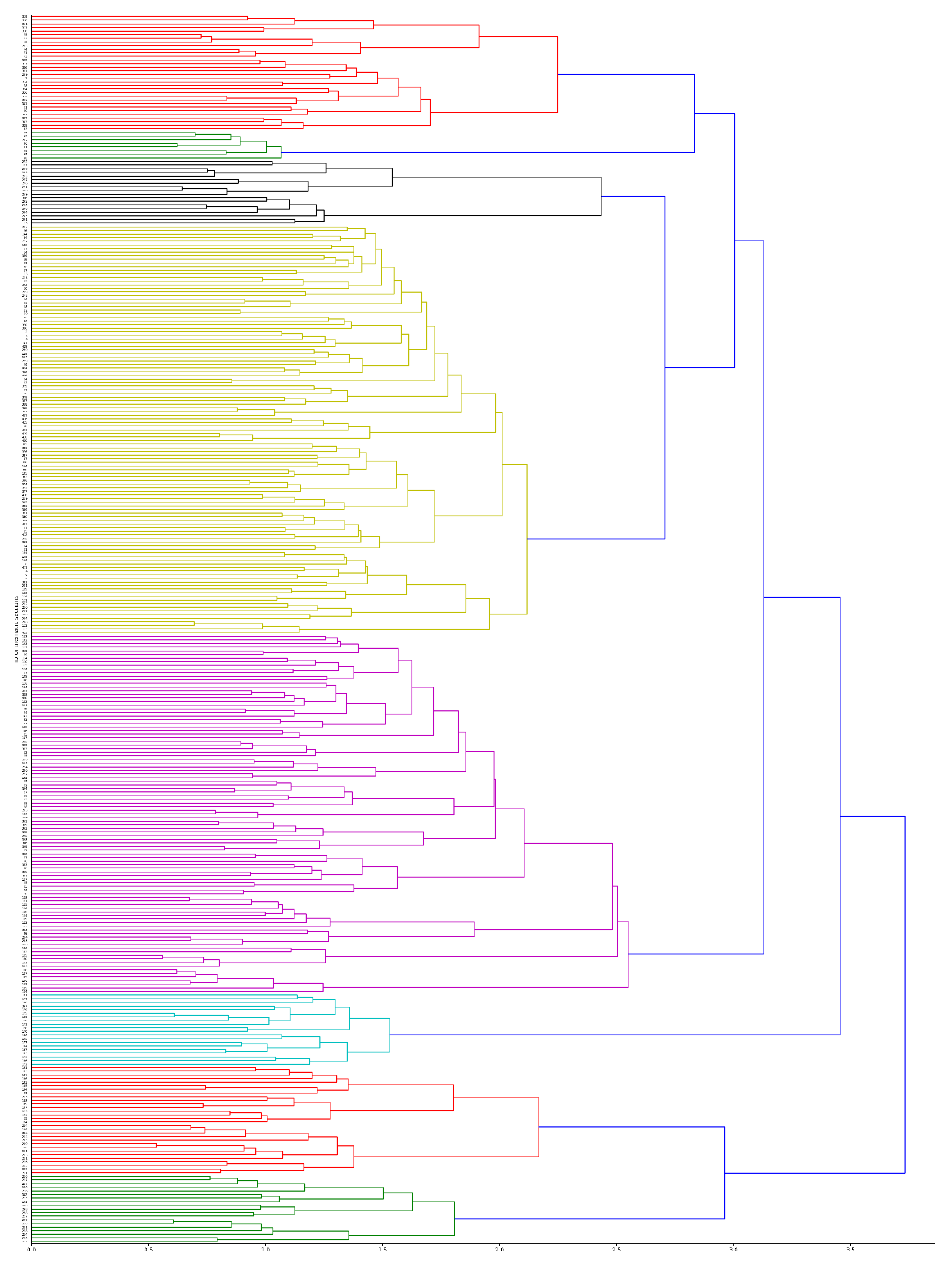
Figure 3. Dendrogram based on hierarchical clustering with Ward’s method and Euclidean distance performed on the tfidf matrix of thematic sections of the Digest.